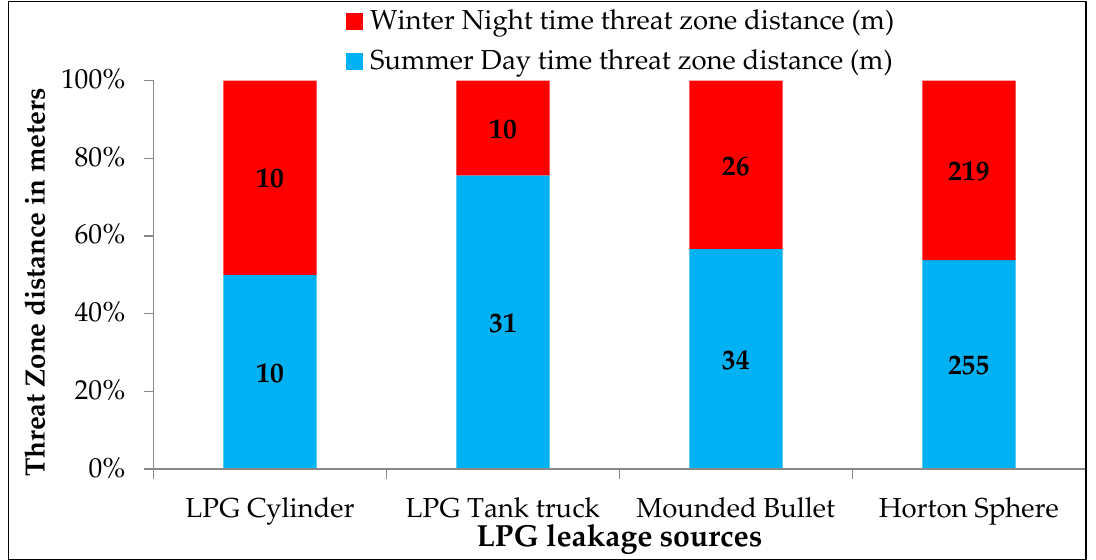
Figure 6. Jet fi re radiation distances for lethal thermal radiation intensity of 37.5 kW/m 2 . Figure 6. Jet fire radiation distances for lethal thermal radiation intensity of 37.5 kW/m 2